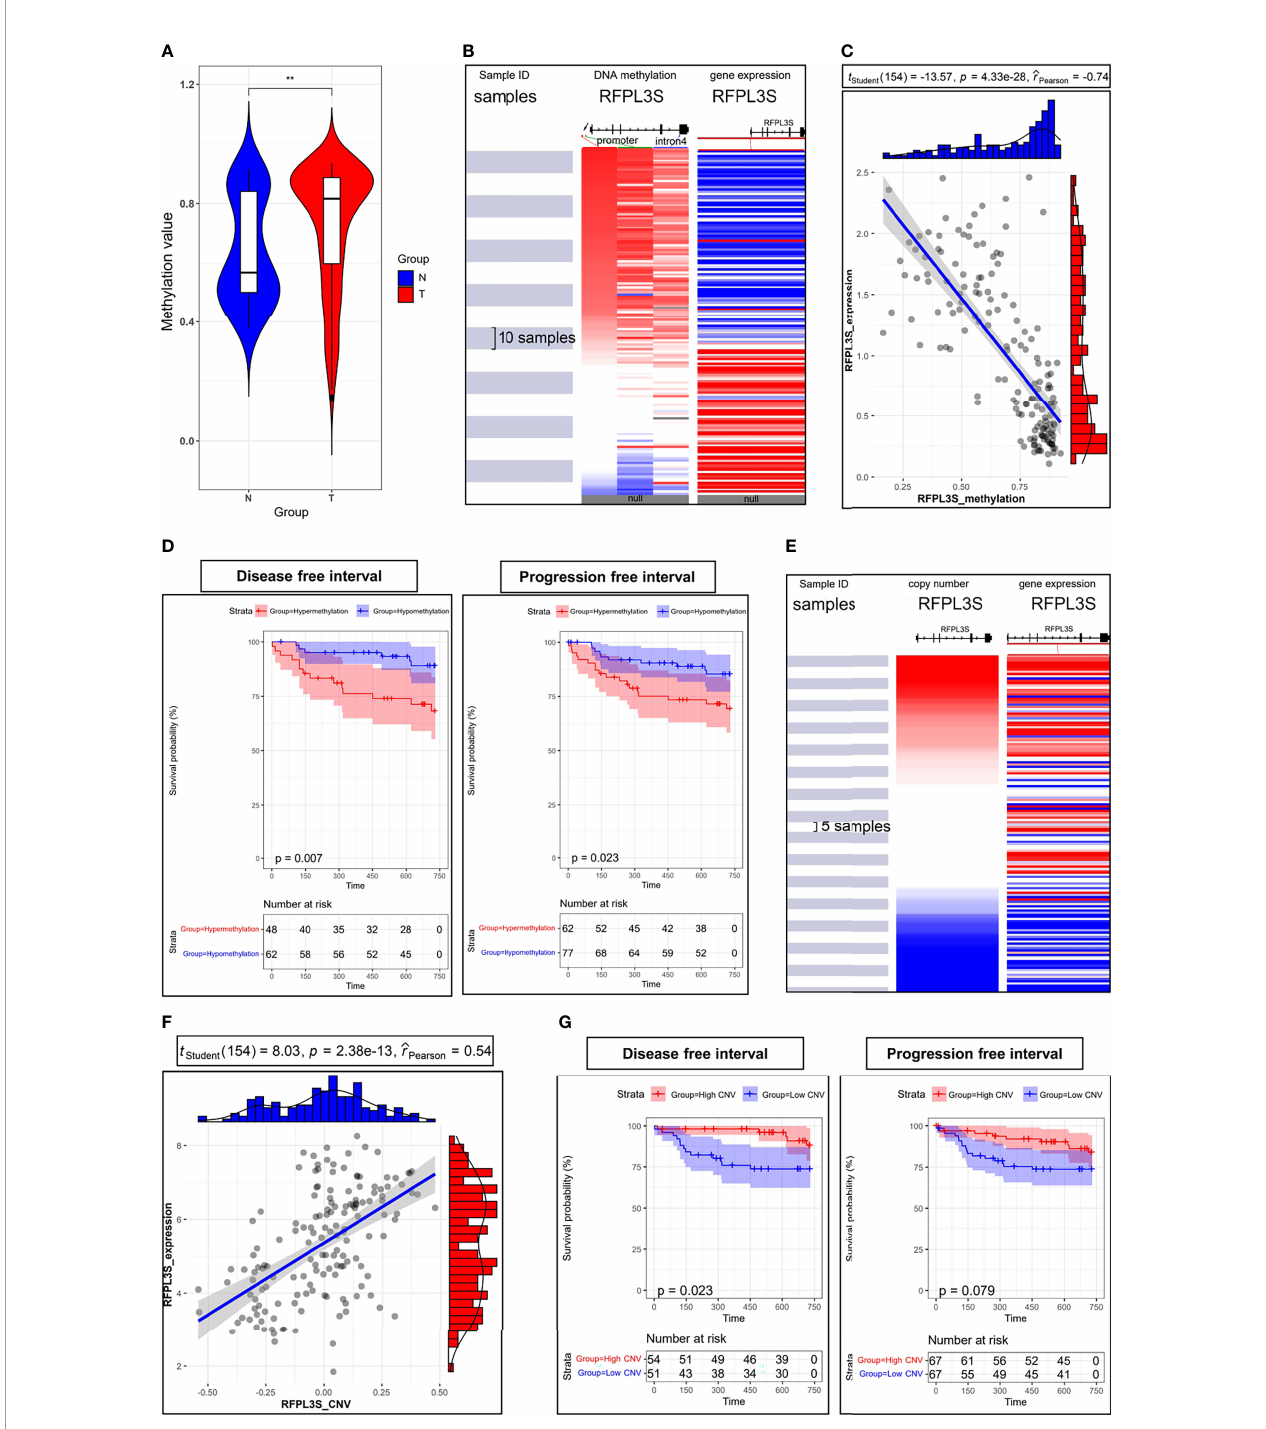
FIGURE 5 | The association between RFPL3S expression, methylation, and copy number in TCGA TGCT cohort. (A) The methylation level of RFPL3S in normal testicular tissues (N) and TGCT (T) tissues. (B) The high methylation regions were located at promoter (indicated by red and green arrows) and intron 4 (indicated by blue arrow). (C) RFPL3S methylation level was signi fi cantly negatively correlated with the expression level. (D) Correlation between RFPL3S methylation level and disease-free interval (DFI) and progression free interval (PFI) of TGCT cohort from TCGA. Patients with high RFPL3S methylation level had lower DFI and PFI. (E, F) Copy number was signi fi cantly positively correlated with the expression of RFPL3S. (G) Correlation between RFPL3S copy number and disease-free interval (DFI) and progression free interval (PFI) of TGCT cohort from TCGA. Patients with high RFPL3S copy number had higher DFI and PFI. CNV, copy number various. The UCSC XENA database was used to download the methylation data, expression data, and prognosis data of RFPL3S from the TCGA TGCT cohort. **P<